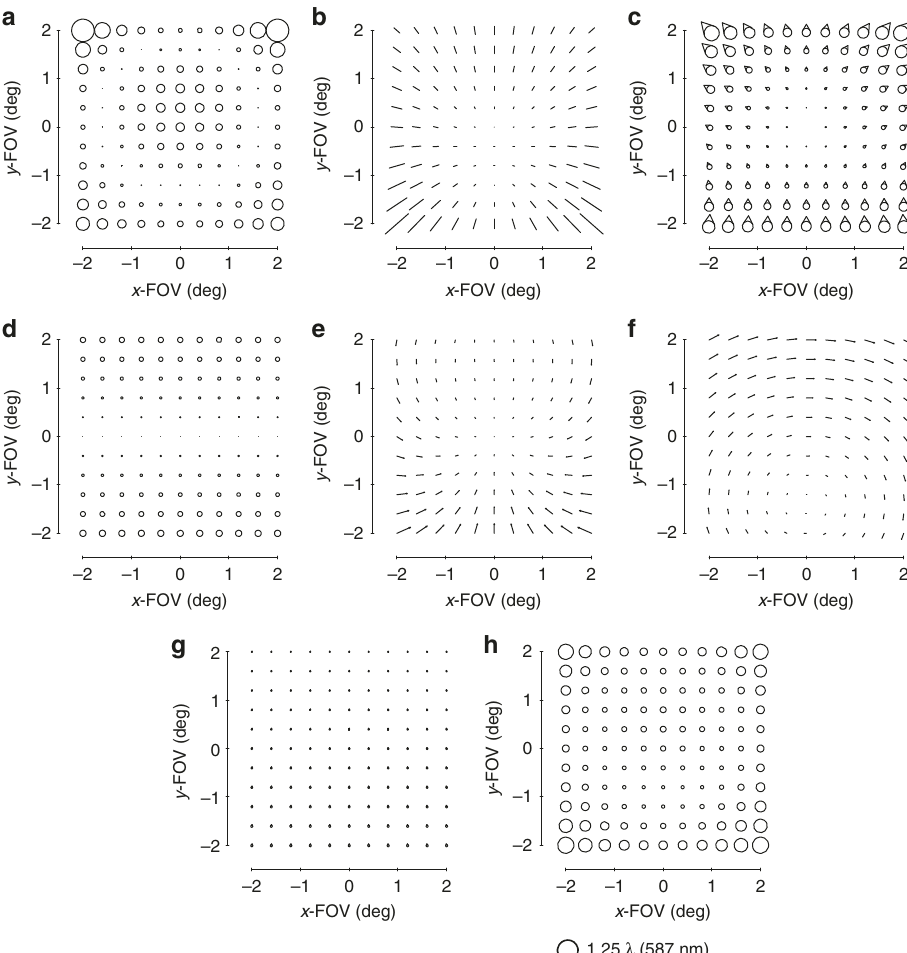
Fig. 6 Zernike-based aberration FFDs after a trefoil surface. After adding a trefoil shape to the primary and secondary mirrors, the aberrations of the system were calculated and are shown in FFDs for a defocus (Z4), b astigmatism (Z5/6), c coma (Z7/8), d spherical aberration (Z9), e elliptical coma (Z10/11), f oblique spherical aberration (Z12/13), g fi fth-order aperture coma (Z14/15), and h RMS